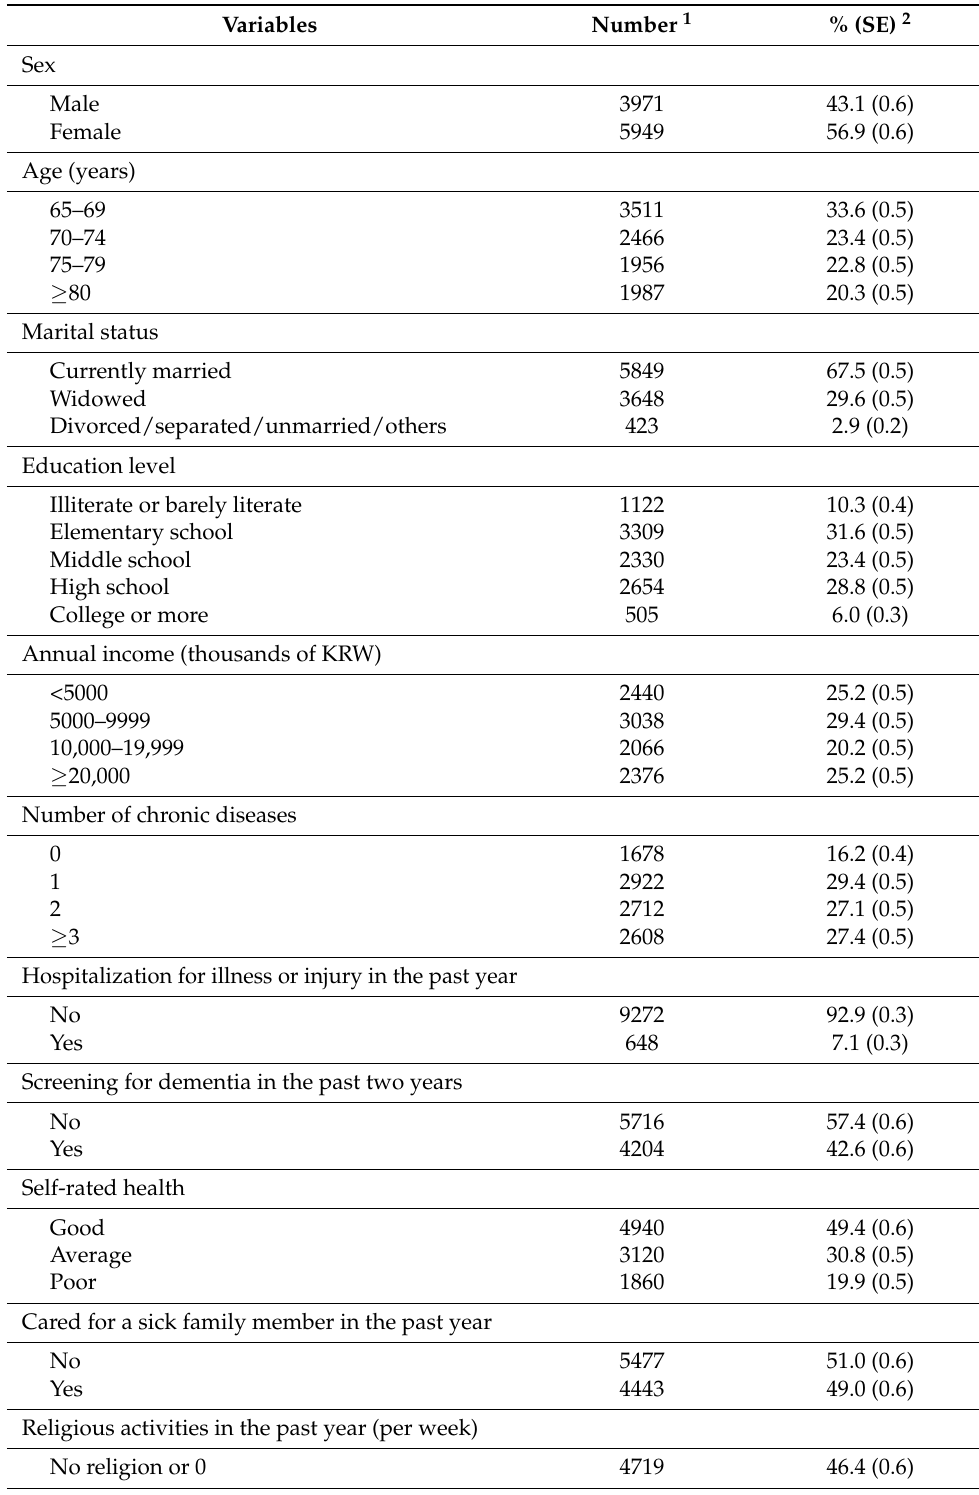
Table 1. Baseline characteristics of the participants ( n =